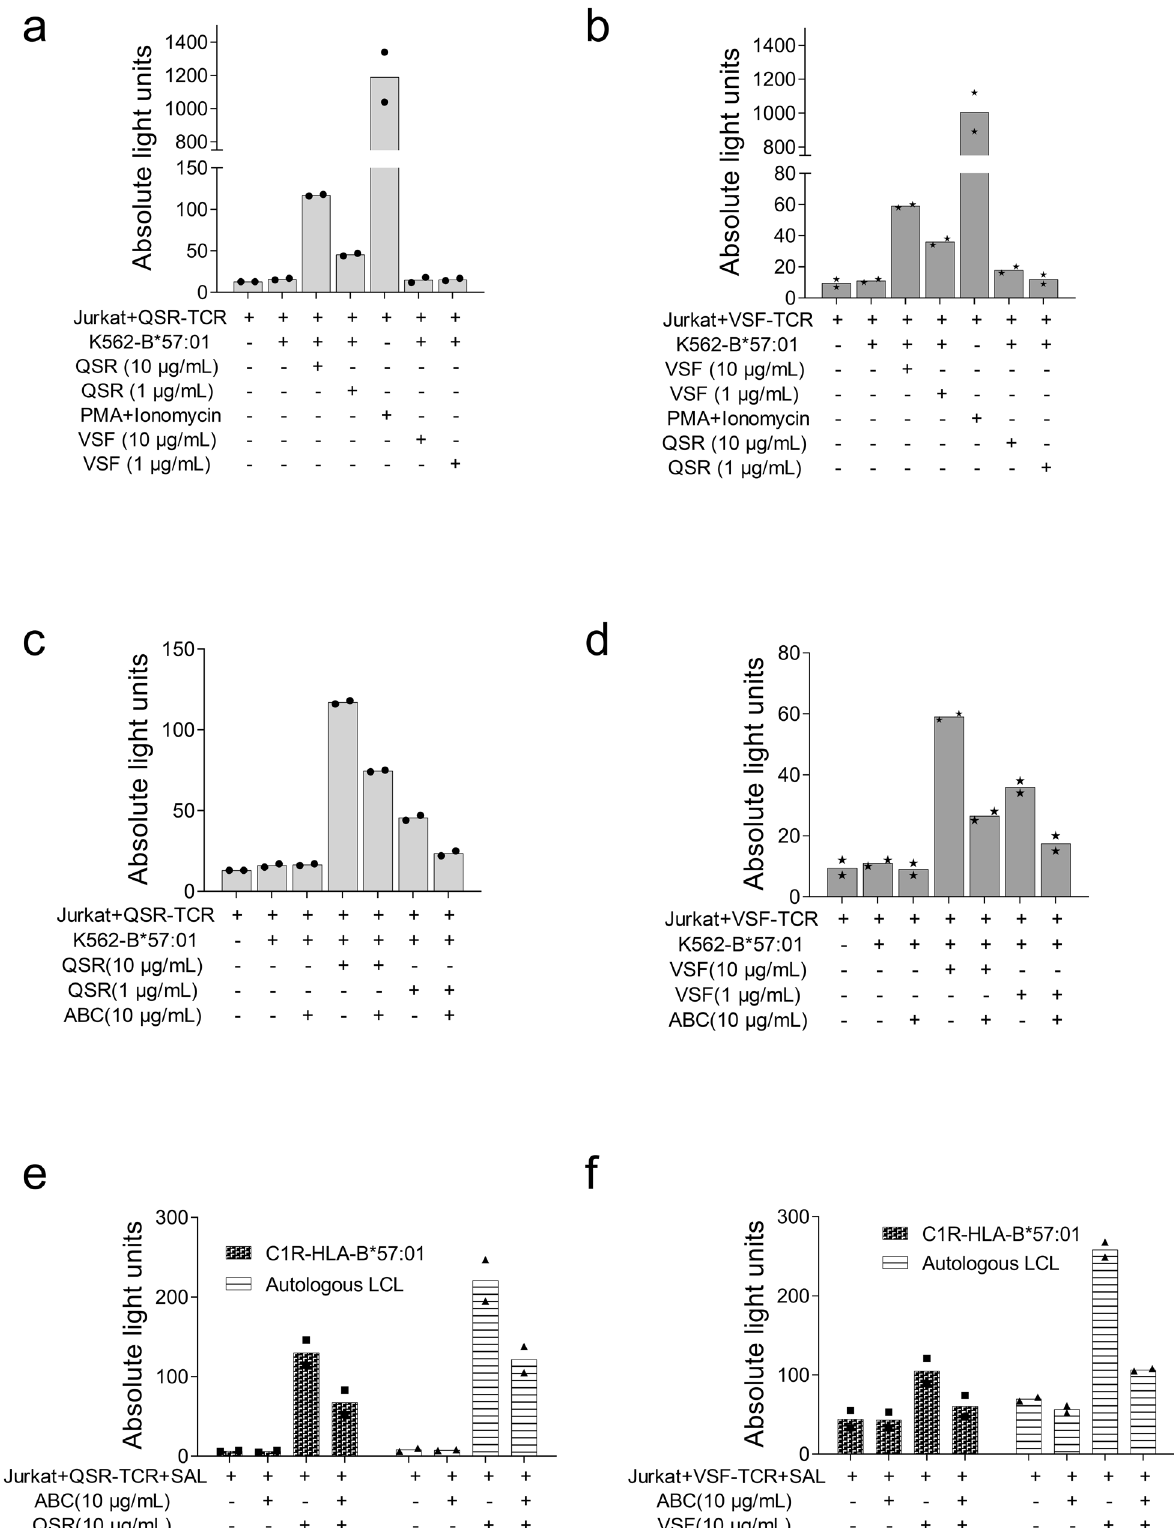
Fig. 9 TCR speci fi c for the EBV epitopes, QSR and VSF, recognize cognate ligand but do not cross-react with ABC modi fi ed self-peptide. Jurkat cells were transfected with the dominant αβ TCR chains and tested for reactivity to individual peptide epitopes with or without ABC. a QSR speci fi c TCR with K562-B*57:01 SAL. b VSF speci fi c TCR with K562-B*57:01 SAL. c QSR speci fi c TCR with K562-B*57:01 SAL, plus or minus ABC. d VSF speci fi c TCR with K562-B*57:01 SAL, plus or minus ABC. e QSR speci fi c TCR with alternative APCs (C1R-HLA B*57:01 or autologous LCLs), plus or minus ABC. f VSF speci fi c TCR with alternative APC (C1R-HLA B*57:01 or autologous LCLs), plus or minus ABC. PMA-Ionomycin is a Jurkat cell activation control. Luciferase luminescence activity is represented as absolute light units. Bars represent mean values from two replicates; dots are individual data points. Antigen presenting cell (APC) single antigen line (SAL), abacavir (ABC), lymphoblastoid cell lines